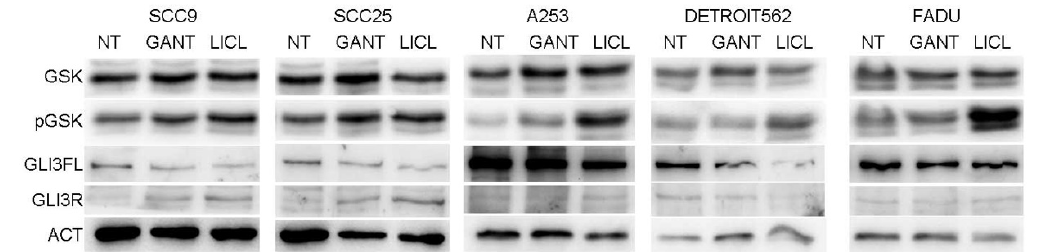
Figure 4. The role of GSK3 β phosphorylation in GLI3 protein activity. Western blot showing phosphorylation of GSK3 β (pGSK) compared to total GSK levels in non-treated (NT) or GANT61 (10 μ M) or LiCL (20 mM) treatment. All HNSCC cell lines show an increase in GSK3 β phosphorylation with LiCl, and three of the lines also with GANT61 treatment. This effect is closely followed by the downregulation of GLI3FL.